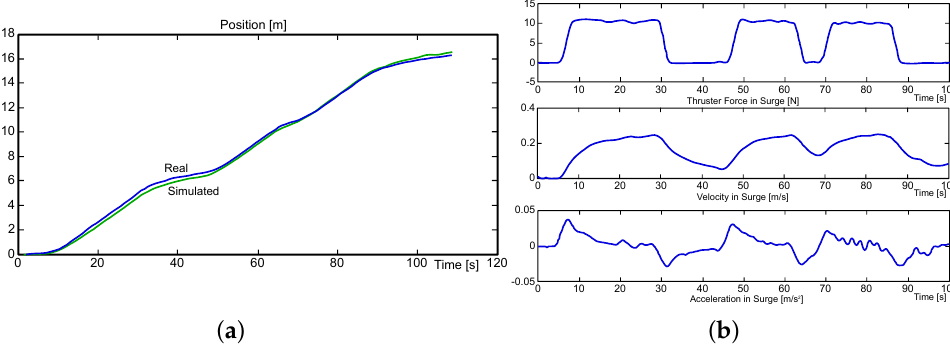
Figure 5. Experimental results of the GARBI vehicle concerning the positive surge motion: ( a ) Posi- tion. ( b ) Forces at the top, velocity in the middle, and acceleration at the bottom [11–13].